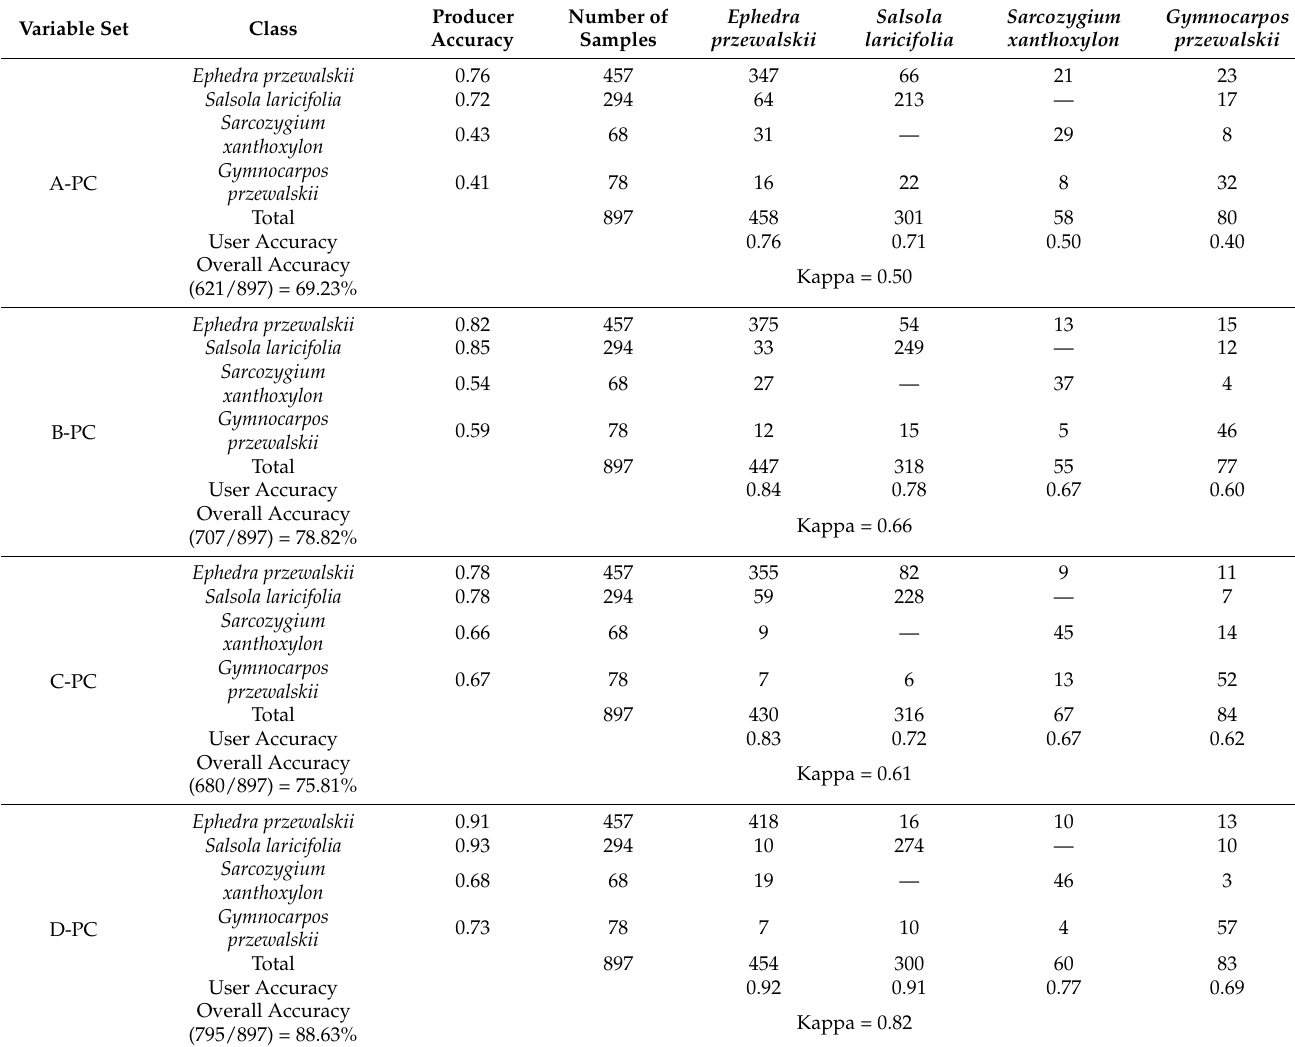
Table 4. Comparison of classification accuracies of individual shrub species maps for four types of variable set generated by the random forest (RF) model.